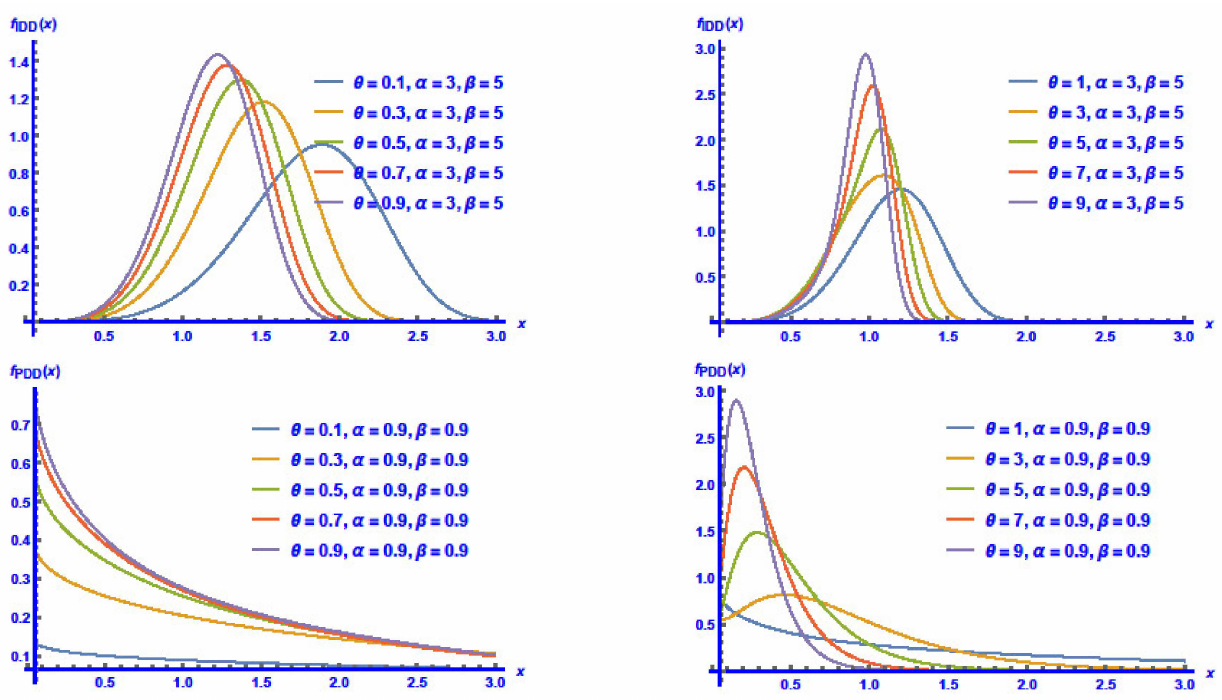
Figure 2. Pdf plots of the PDD with various values of